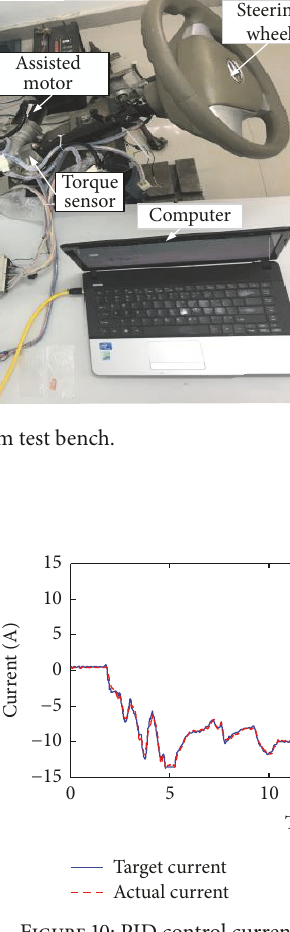
Figure 10: PID control current tracking curve when in